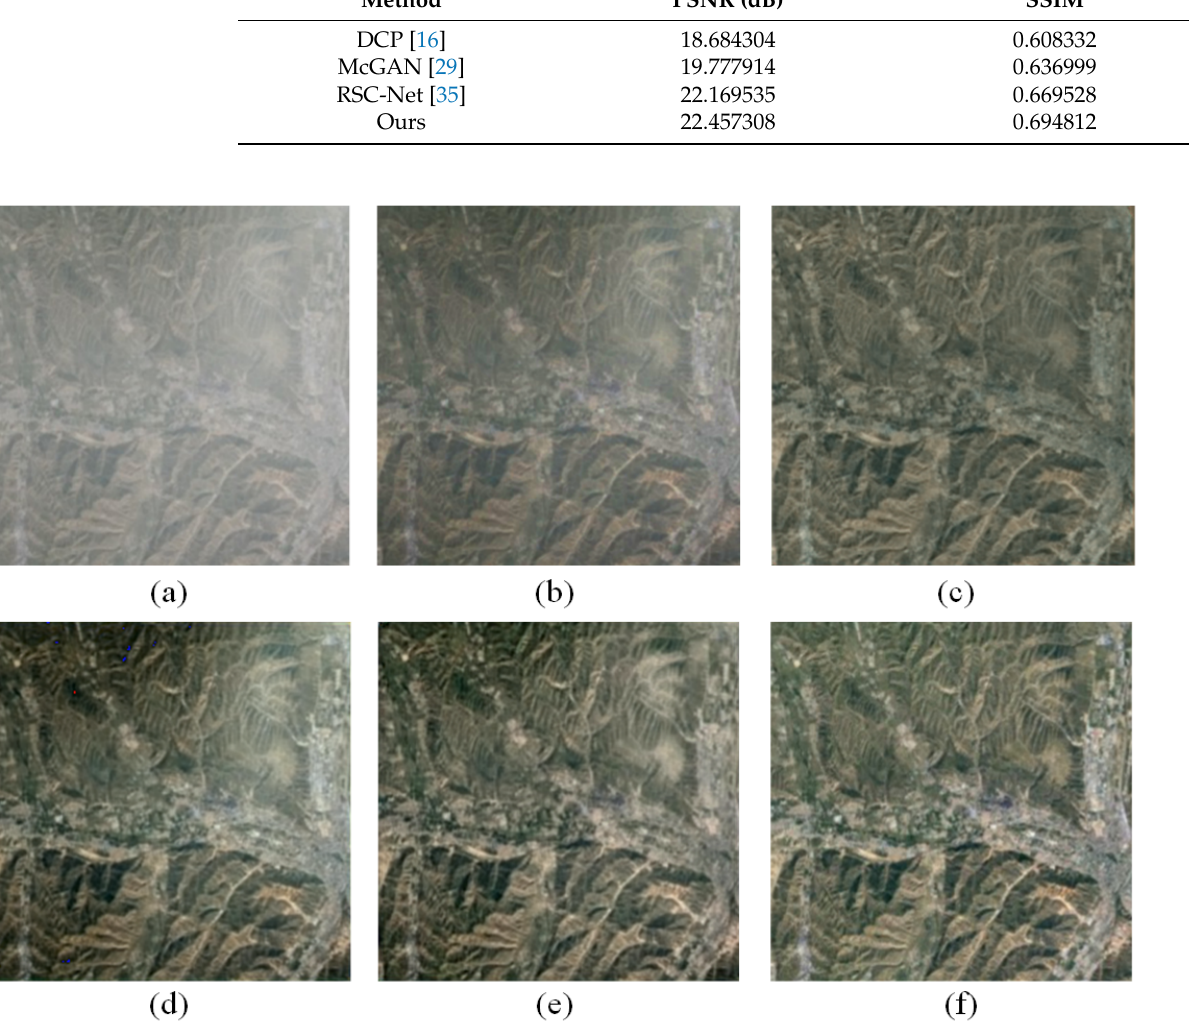
Figure 13. Thin cloud removal results of various methods on a cloudy image from the RICE1 test set: ( a ) input cloudy image, ( b ) result of DCP, ( c ) result of McGAN, ( d ) result of RSC-Net, ( e ) result of our method, and ( f ) reference cloud-free